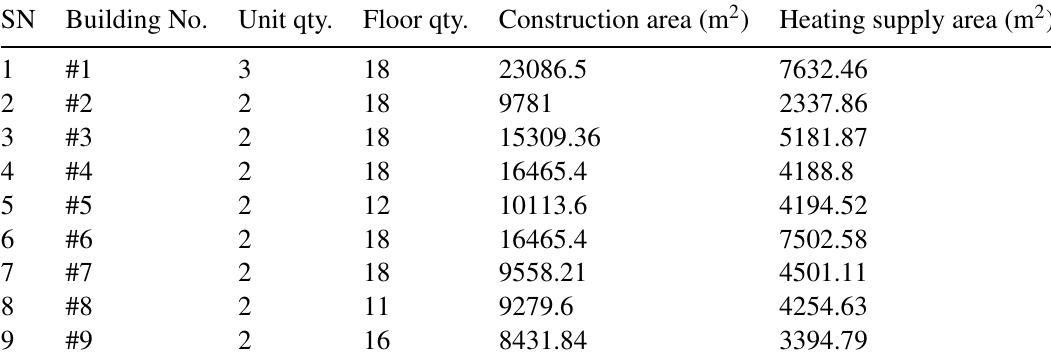
Table 2 Statistics of building condition in the